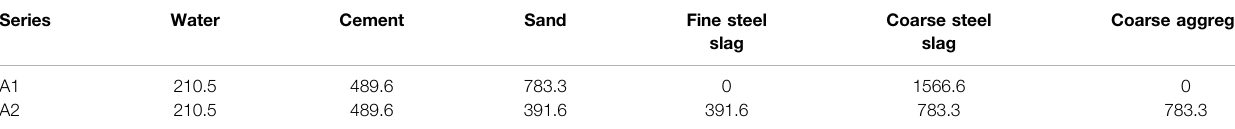
TABLE 1 | Mixture of the two series of MDC (by weight, units: kg/m 3 ).